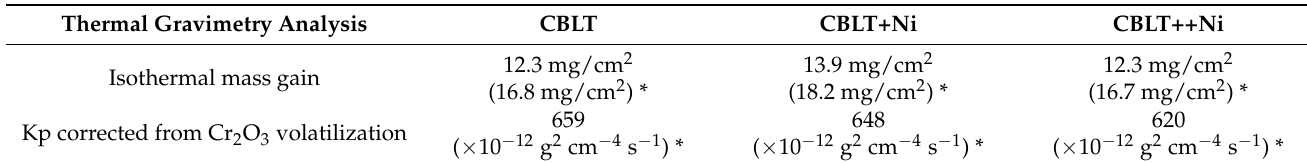
Figure 6. The isothermal parts of the TG curves (plotted as mass gain versus time): A : the CBLT alloy; B : the CBLT+Ni alloy; C : the CBLT++Ni alloy. Table 4. Values of the temperature of the total mass gain achieved during the 70 h–isothermal stage and of the parabolic constant of oxidation after correction from chromia volatilization * (rate estimated at Kv = 200 × 10 − 10 g cm − 2 s − 1